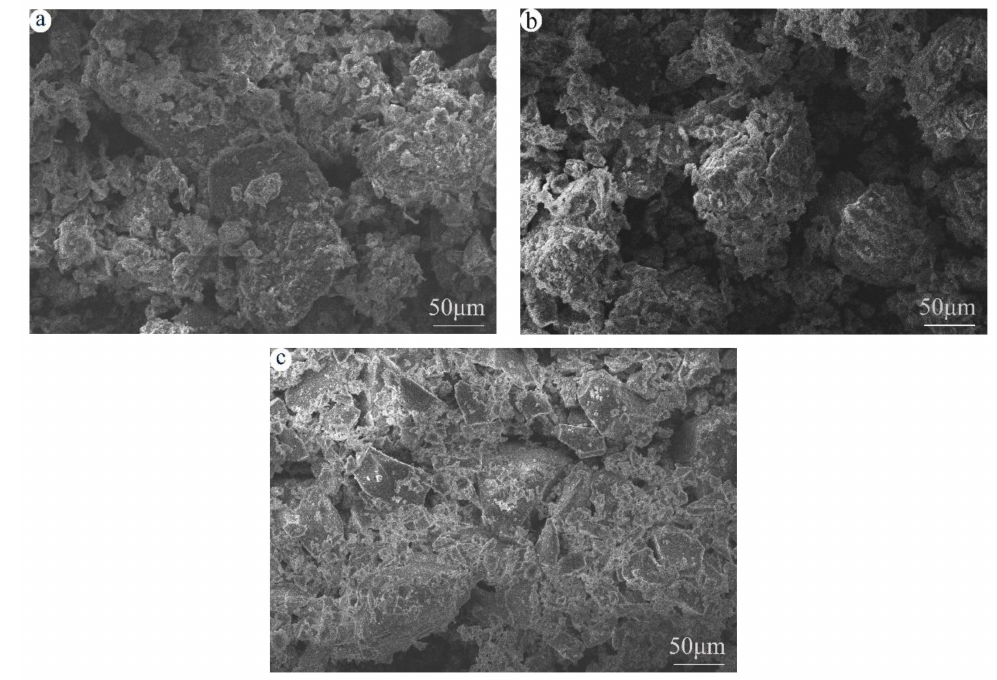
Figure 7. SEM images of ( a ) raw CGF; ( b ) metakaolin; and ( c ) ground granulated blast furnace slag.